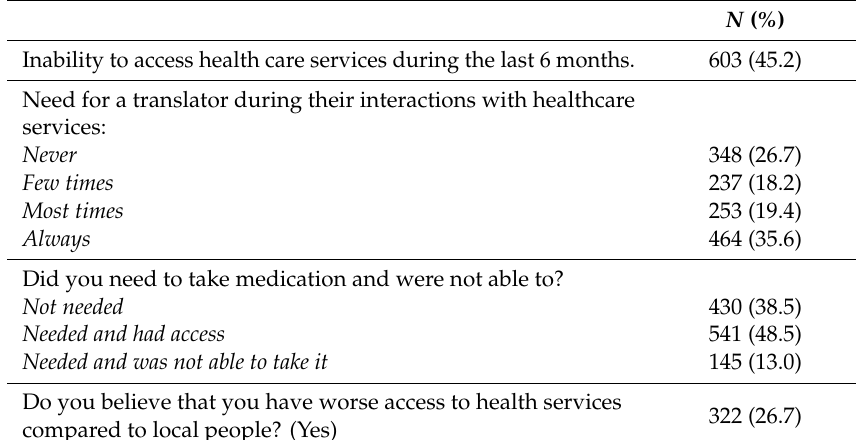
Table 4. Migrant access to and interaction with health care